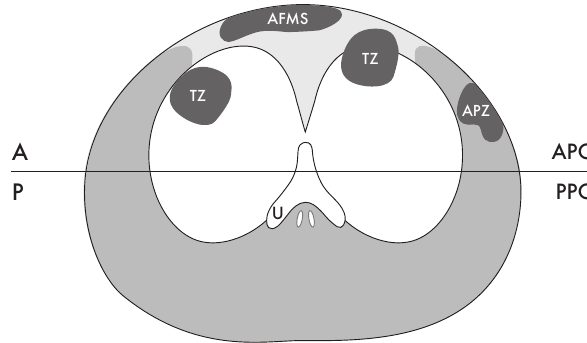
Fig. 1. Anterior part is defined as area anterior to prostatic